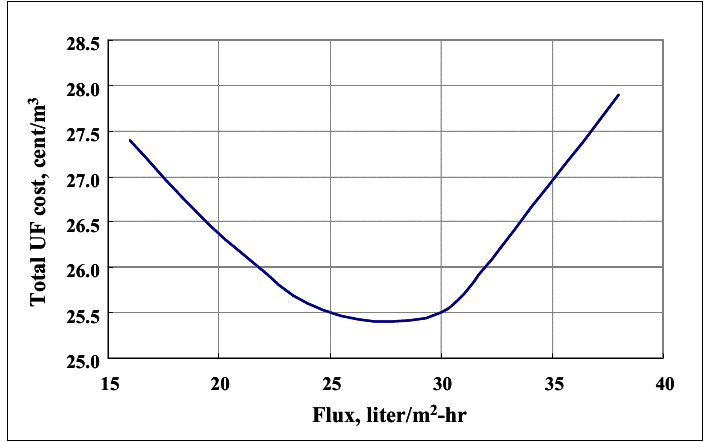
Figure 3. The extra UF cost for a treatment plant with a capacity of 20,000 m 3